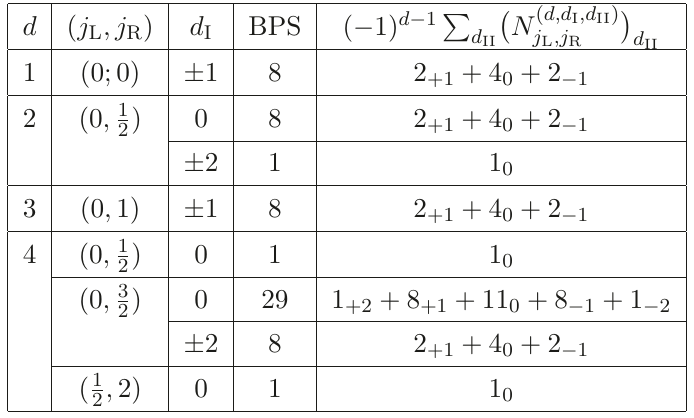
Table 4 . The BPS indices N d for 1 ≤ d ≤ 4 of the (2 , 2) model with the rank j L ,j R